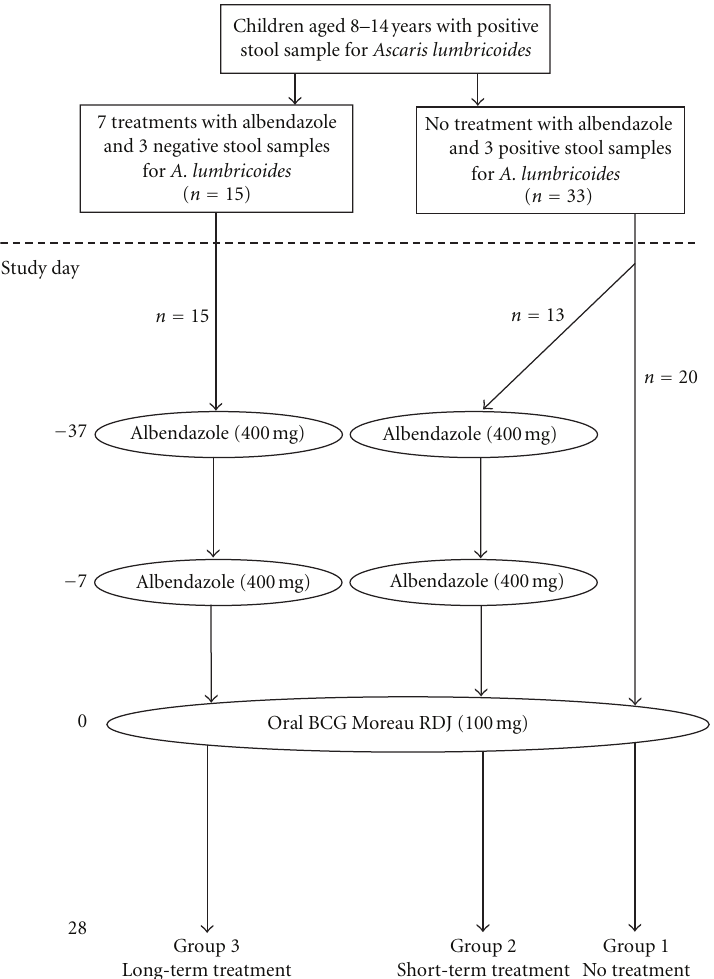
Figure 1: Study design. All eligible children had documented stool samples with Ascaris lumbricoides a year before the start of the study. Children were selected into study groups on the basis if they had or had not received 7 repeated doses of 400 mg of albendazole every 2 months over the previous 16 months. Children who had not received long-term albendazole and who continued to have ascariasis were allocated to 2 groups. Group 1: active A. lumbricoides infection; Group 2: short-term anthelmintic treatment. Children in Group 2 were given 2 single doses of 400 mg albendazole separated by 30 days. Children who had received long-term anthelmintic treatment were selected into Group 3. Children in Group 3 were given 2 single doses of 400 mg albendazole separated by 30 days. All children received a single dose of oral BCG Moreau RDJ. Blood was collected immediately before vaccination and at 28 days after vaccination to measure IFN- γ responses to